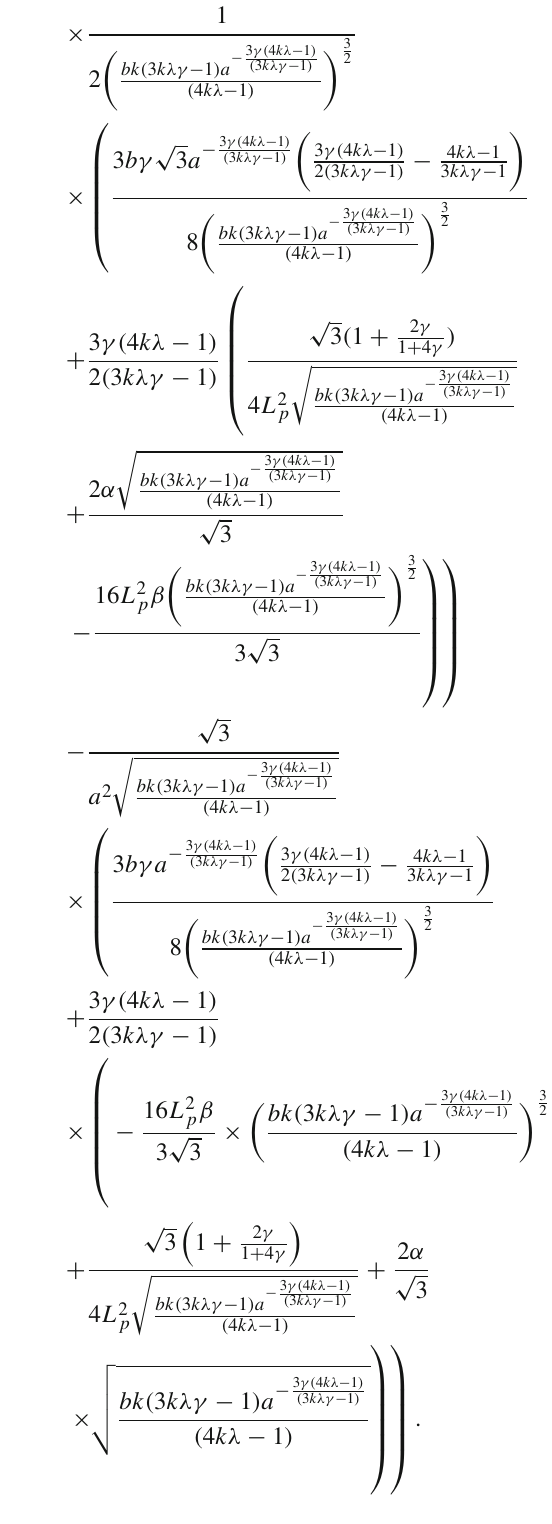
(cid:7)(cid:7) The graphical behavior of S versus a is shown in T Fig. 5 for same constant values as mentioned above. We observe that all the trajectories express the positive behav- ior which represent non-equilibrium state of the